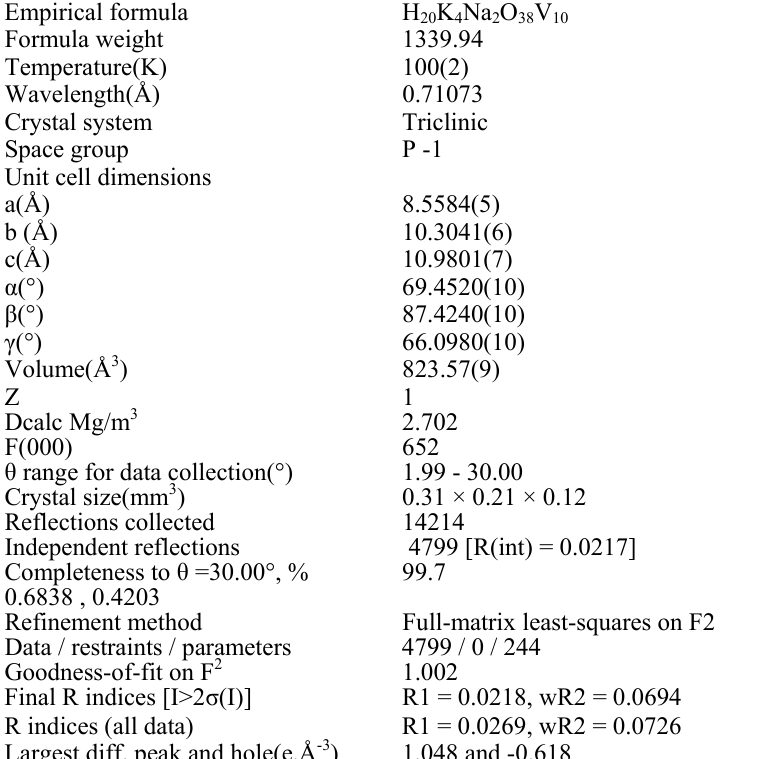
Na V O .20H 4 2 10 28 2